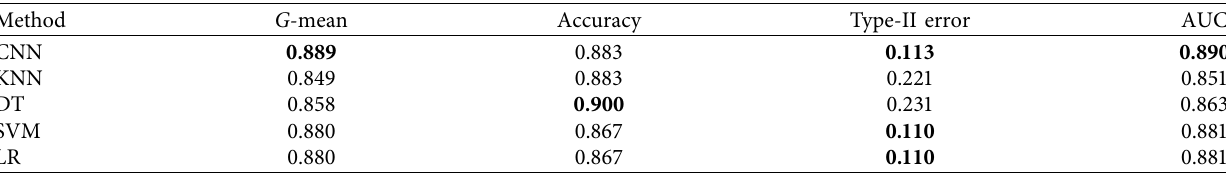
Table 10: The performance of CNN and other four models on A